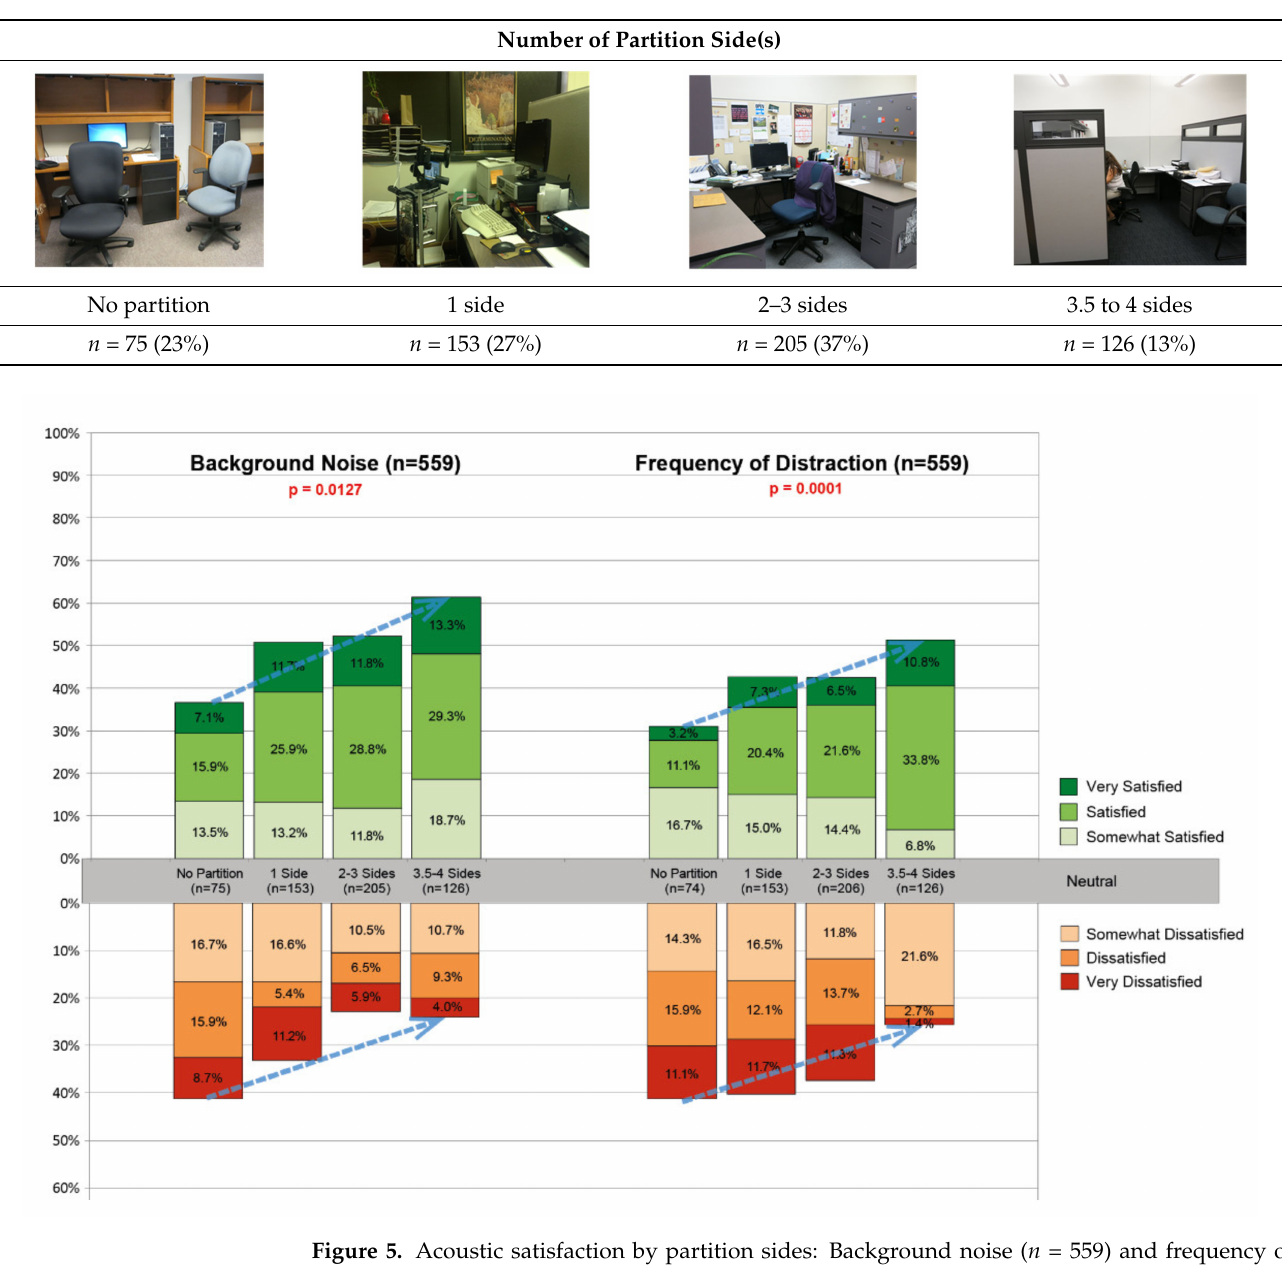
Figure 5. Acoustic satisfaction by partition sides: Background noise ( n = 559) and frequency of distraction ( n = 559) in open-plan